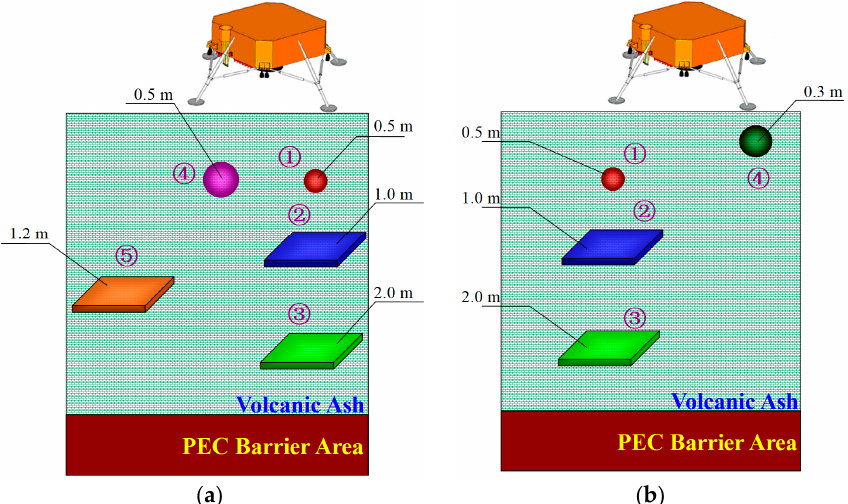
Figure 5. Two single-station laboratory data acquisition systems from an experimental lunar exploration system Chang’E-5. The ε r = 3 volcanic ash replaces lunar soil as background for buried objects. In ( a ), the buried objects are respectively 1 (cid:13) Basalt, 2 (cid:13) Teflon, 3 (cid:13) 5 (cid:13) Granite and 4 (cid:13) Metal. In ( b ),